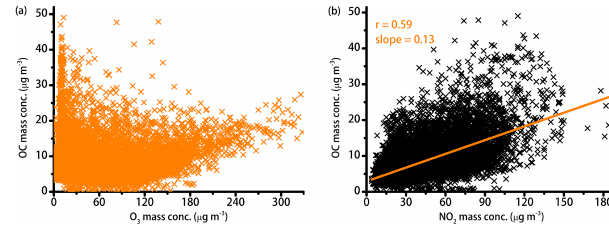
Figure 11. Scatter plots of OC vs. O 3 (a) and OC vs. NO 2 (b) in Shanghai.